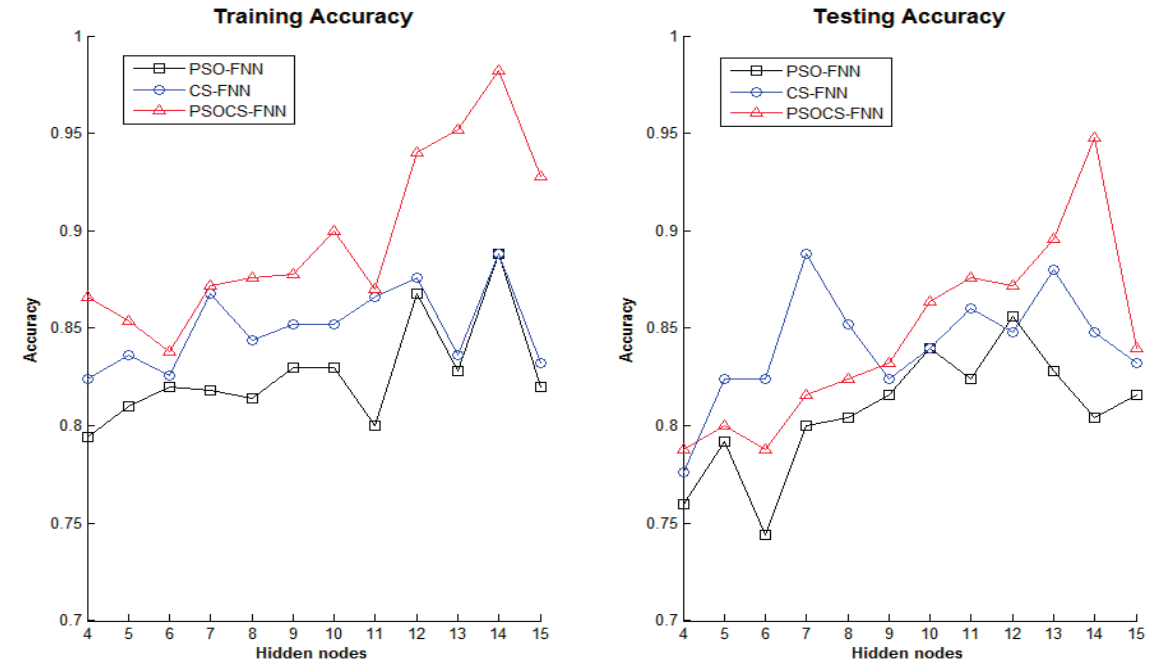
Figure 6. Accuracy rate of PSO-FNN, CS-FNN, and PSOCS-FNN in the